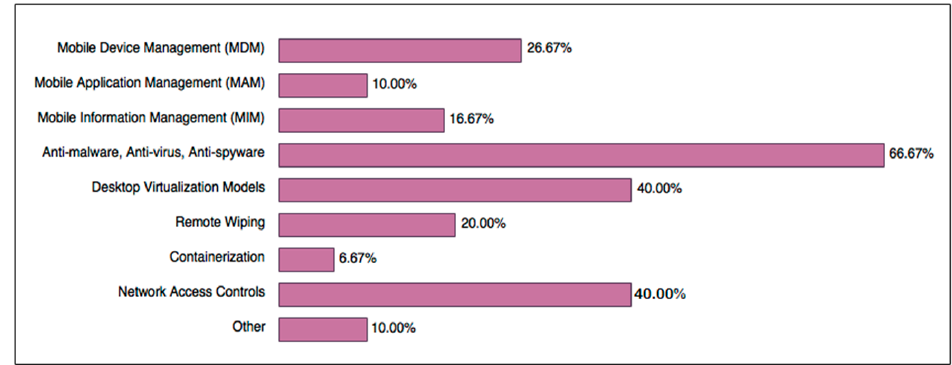
Figure 1. Active BYOD security mechanisms in Australian organisations.